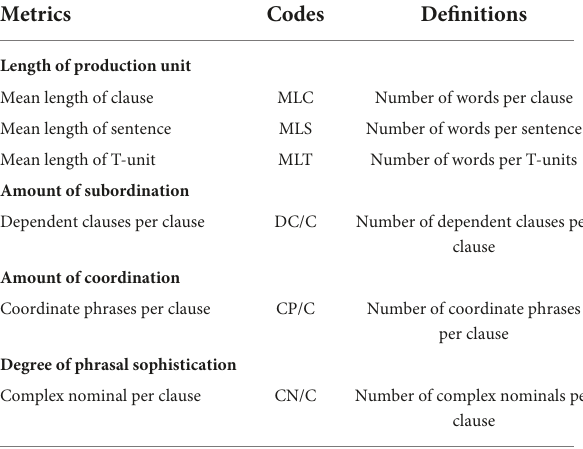
TABLE 2 The six traditional complexity metrics from